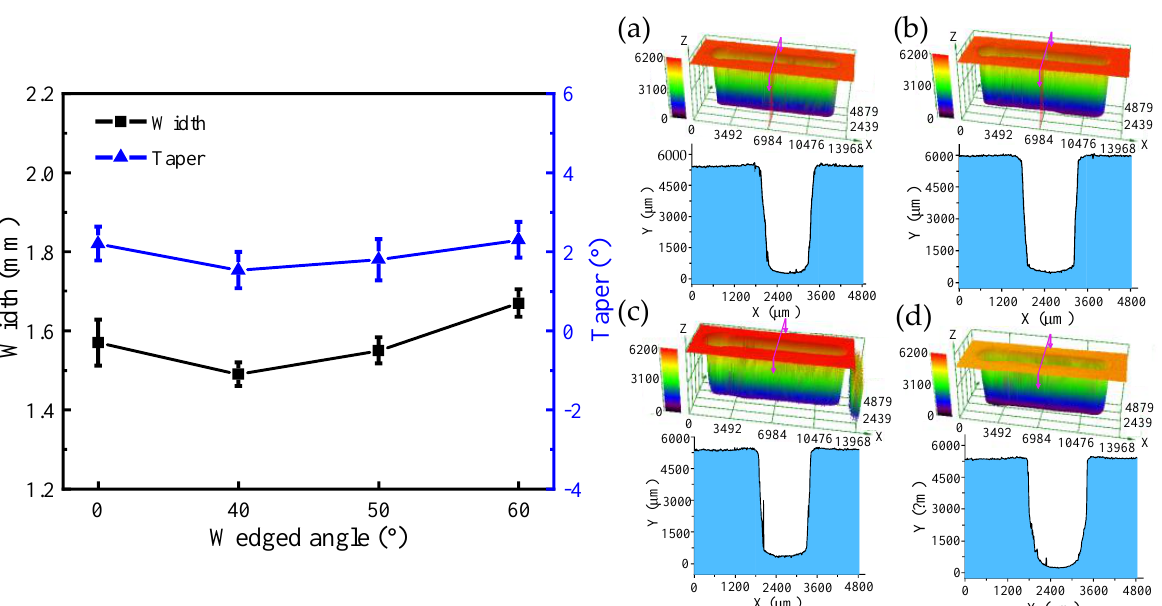
Figure 10. The dimension and 3D profile of DNGs milled with different wedged angles in the end face of the tube tool: ( a ) wedged angle = 0°; ( b ) wedged angle = 40°; ( c ) wedged angle = 50°; and ( d ) wedged angle = 60°.